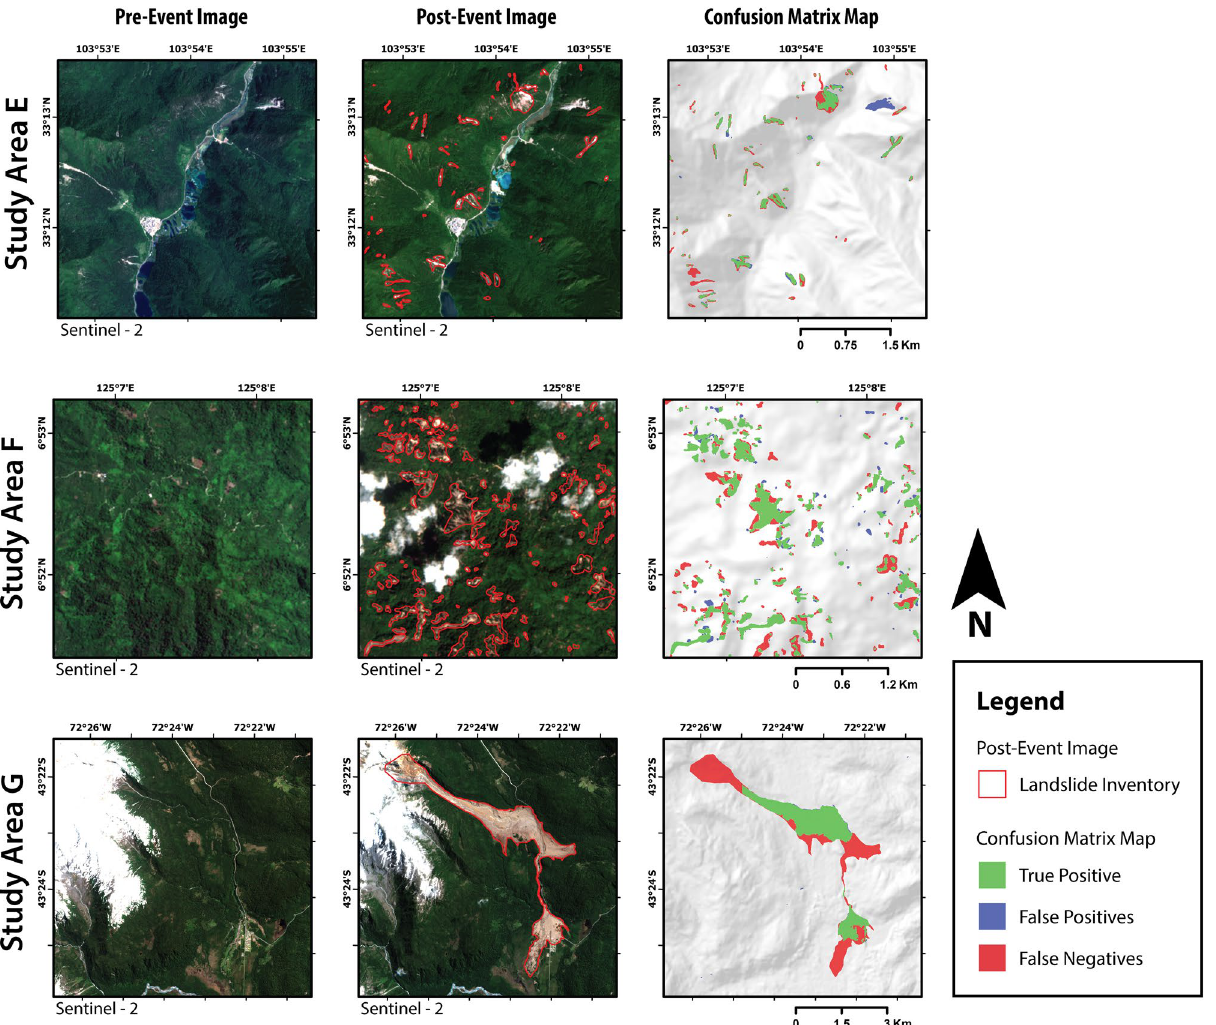
ALL Figure 5. Result of applying the trained CNN model ( M 6 ) on study area “E” to “G”. These three study areas were not used for training any CNN model; hence they were completely used as the testing region. The results ALL highlight the generalizing ability of M 6 to map event landslides. Every row shows a fixed view from one study area with pre-event image (left), post-event image with polygons from landslide inventory (middle), and output from CNN as a confusion matrix map (right). The majority resampling method was used to visualize the confusion matrix map. The cloud and snow-cover masks have not been shown for clarity, but the affected region was not used in the training and prediction process. The maps were created using ArcGIS Pro v2.4 (https:// www. esri.